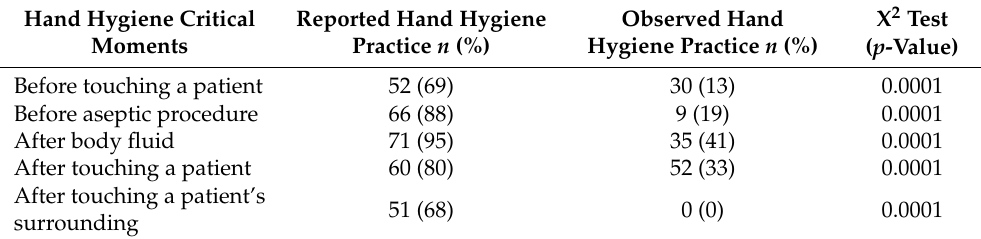
Table 4. Observed versus reported hand hygiene practice at different critical moments of hand